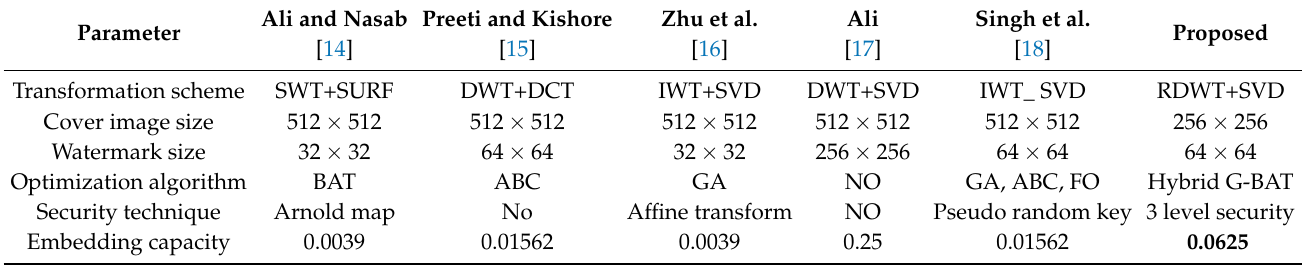
Table 10. Comparison analysis of our proposal against those considered the state-of-the-art.